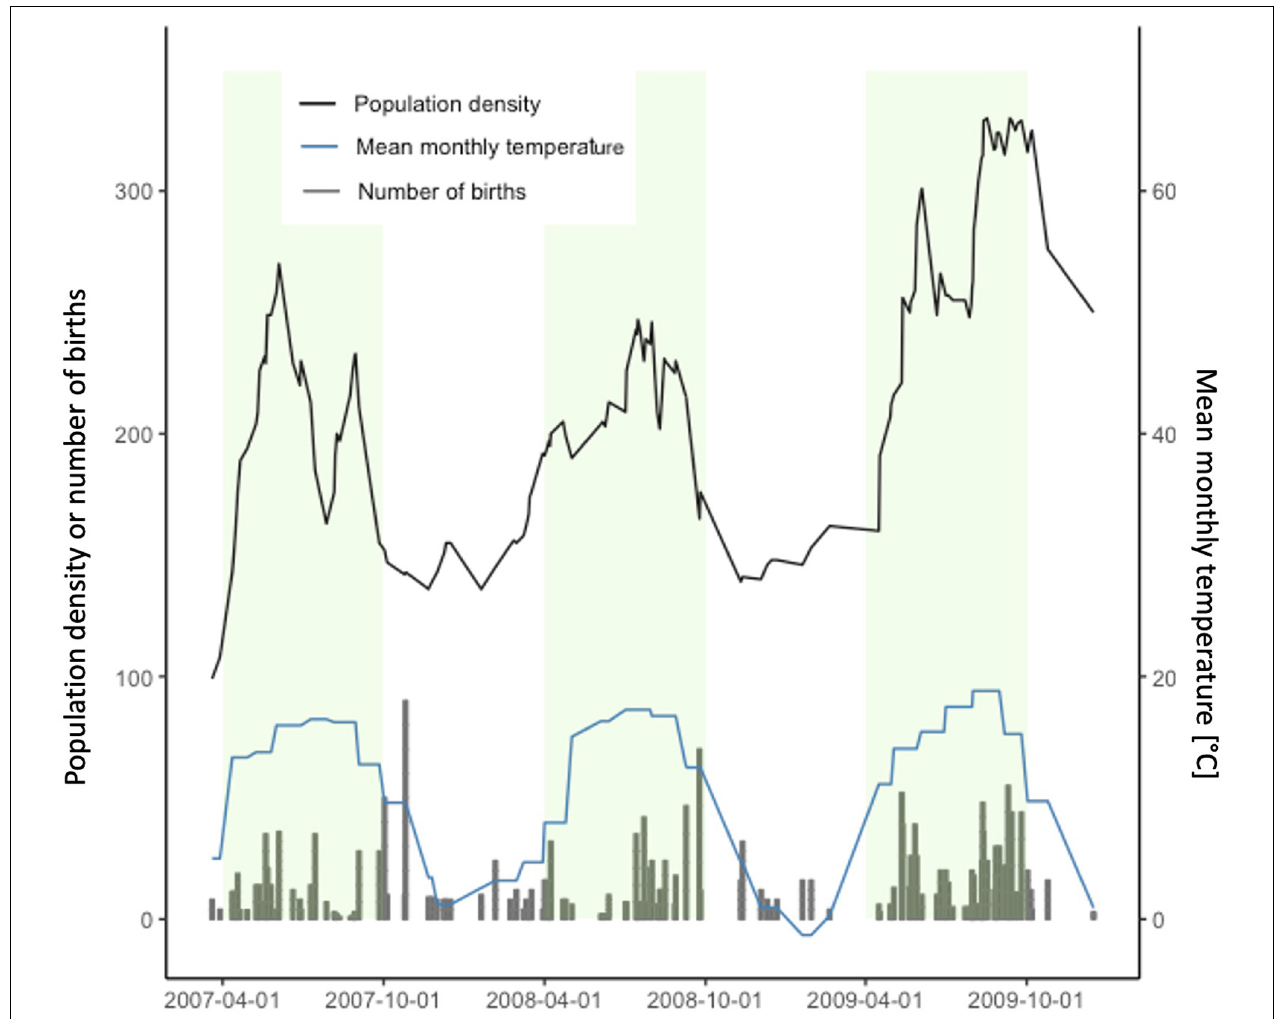
FIGURE 2 | Population density (number of individuals), mean monthly temperature in the barn and number of births over time. Green shaded areas represent the summer months (April–September) and white areas refer to winter months